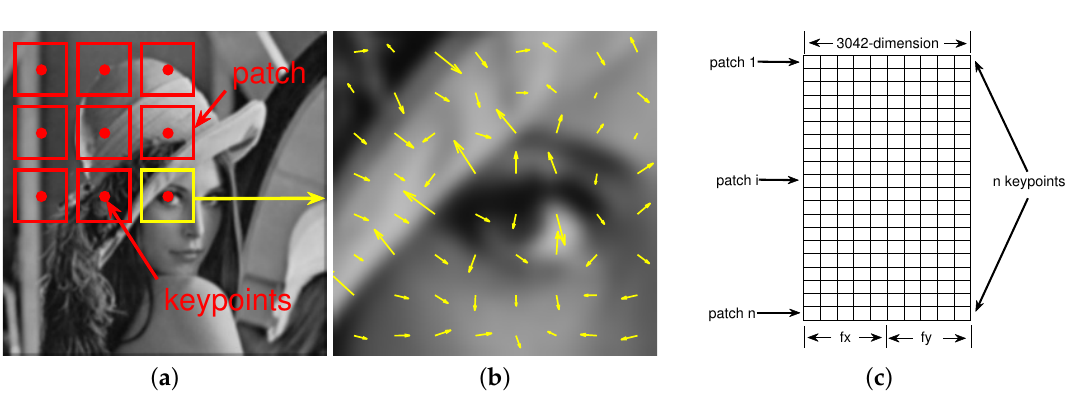
Figure 2. Keypoints and the patches: ( a ) some keypoints and the patches centering them; ( b ) the gradient field on a patch; ( c ) a 3042-dimensional feature space for dimension